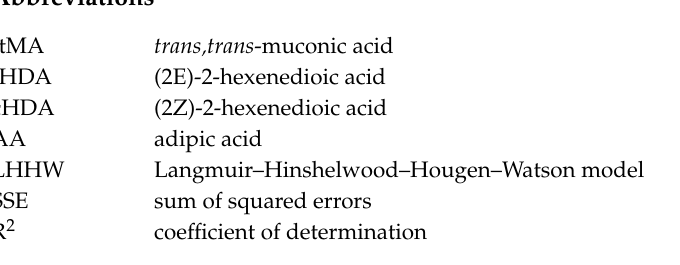
Figure S1: Results of the regression with the model LHHW_13P (Case 3). Table S1: Experimental data at di ff erent temperatures for trans,trans-muconic acid hydrogenation on Pt / C 5% at 4 bar of hydrogen. Table S2: Calculated values for the di ff erent models with 95% confidence intervals and regression